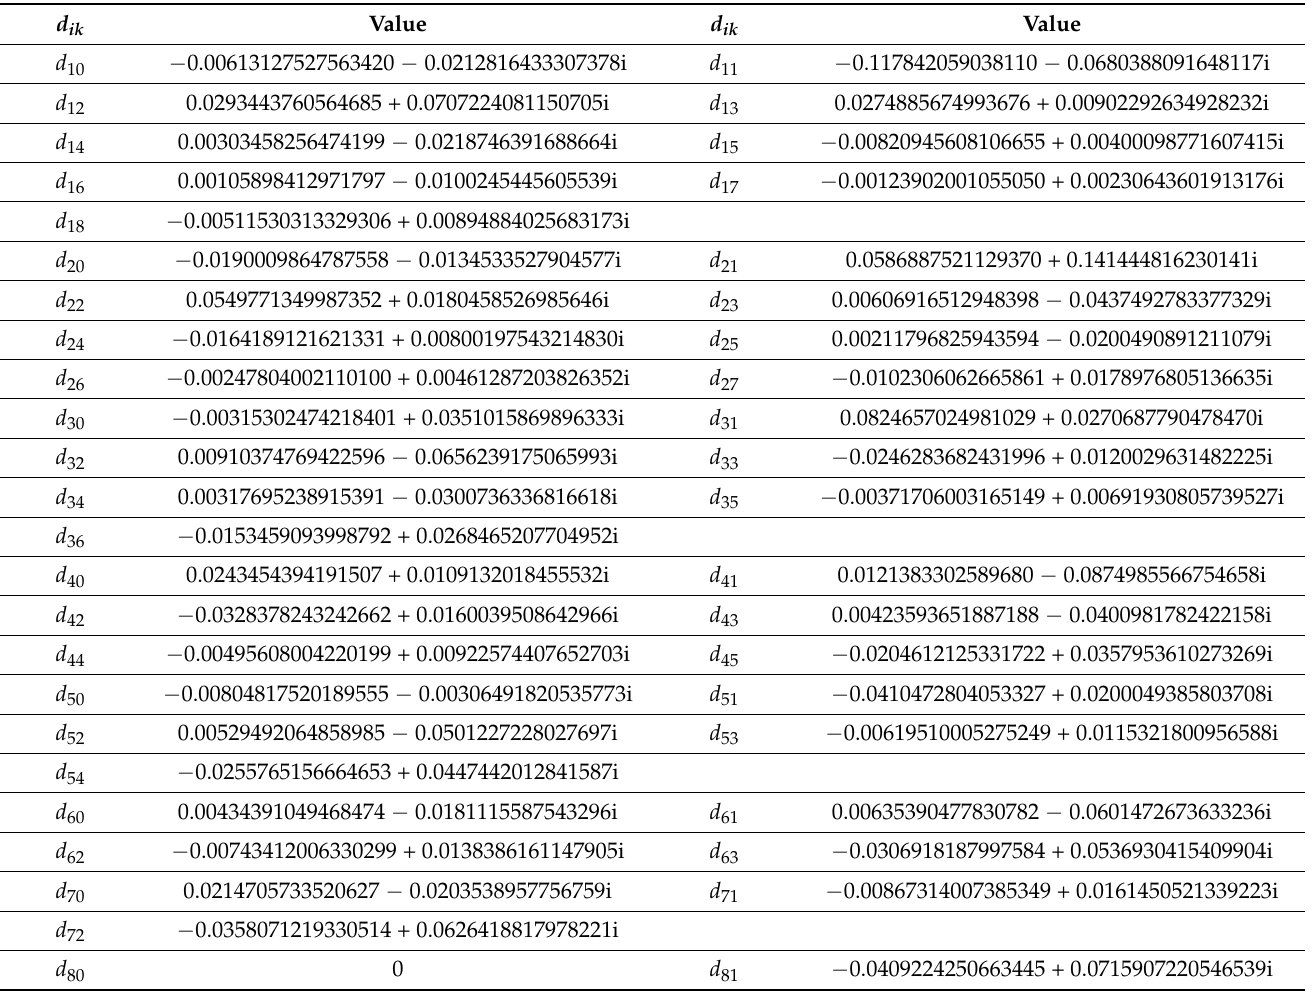
Table 2. The values of the complex coefficients d 1 k , d 2 k , d 3 k , d 4 k , d 5 k , d 6 k , d 7 k , d 8 k .